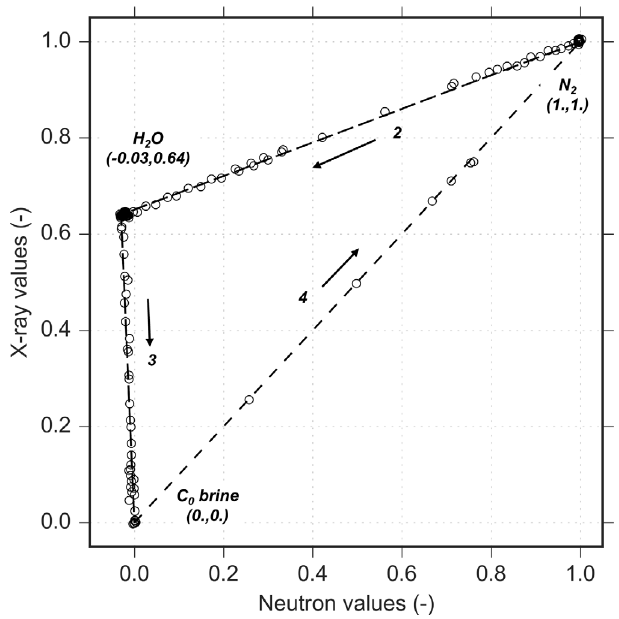
Fig. A2. Scatter plot of X-ray and Neutron values during the calibration experiment. Arrows indicate the injection sequences described in the text. X-ray and Neutron values are obtained with equation